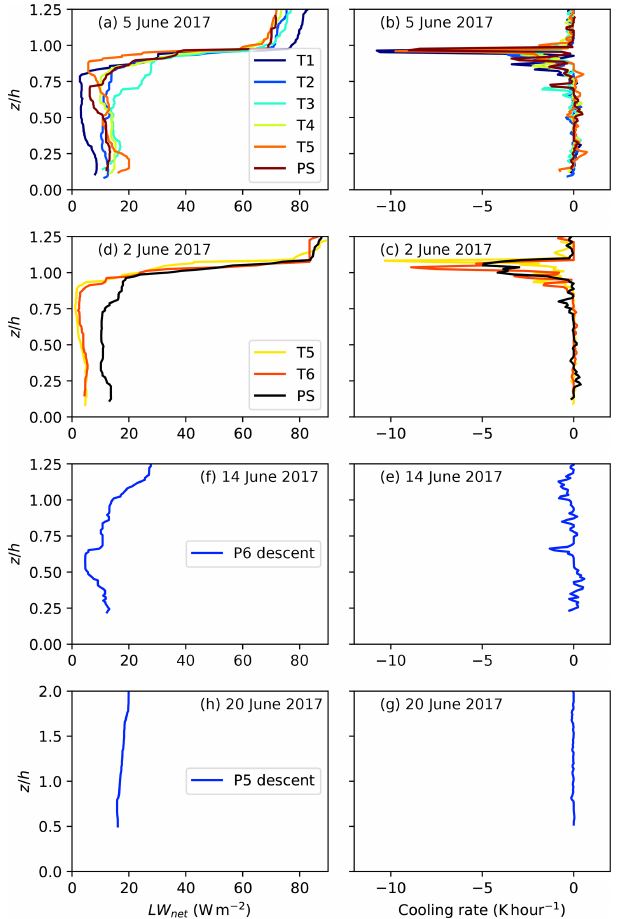
Figure B1. Vertical profiles of the net terrestrial radiative energy flux LW net and of the cooling rate associated with the vertical diver- gence of LW net . The altitude is normalized by the cloud-top height h so that individual profiles can be